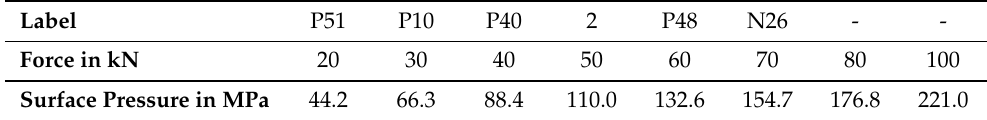
Table 2. Set force values for the experimental investigation.